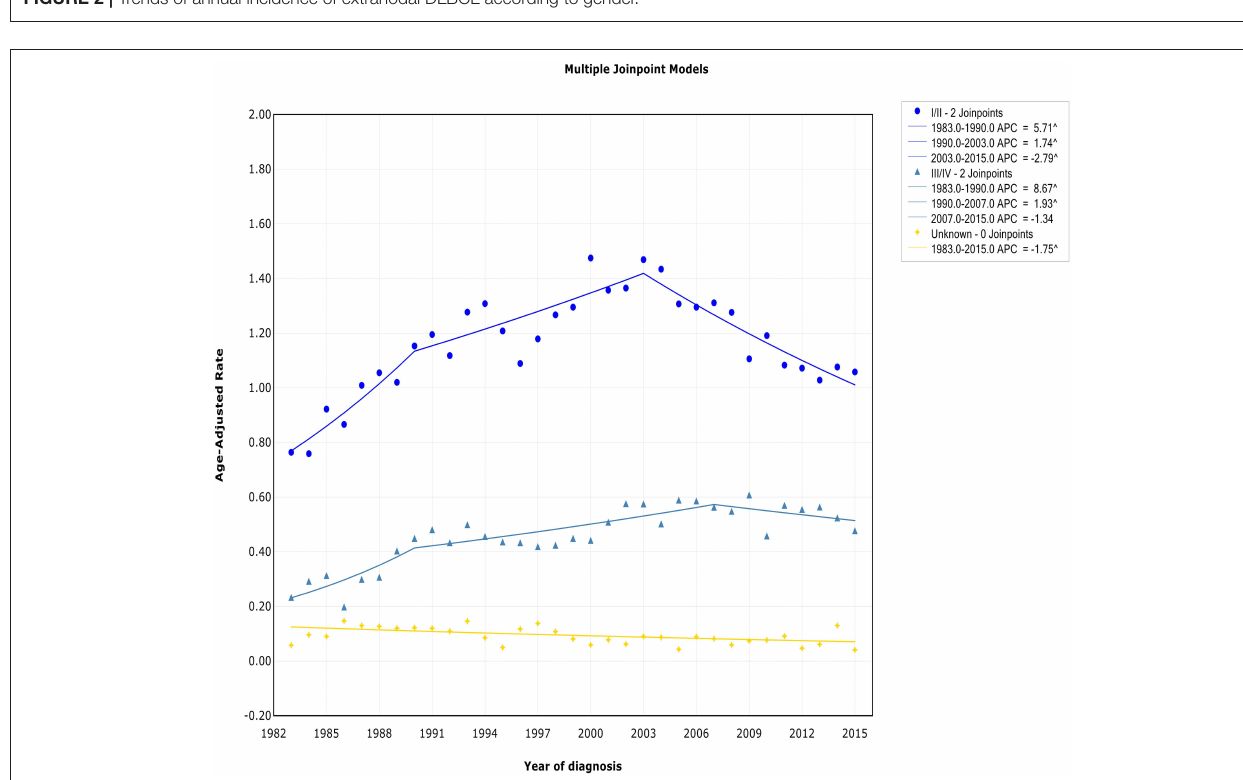
FIGURE 3 | Trends of annual incidence of extranodal DLBCL according to stage.